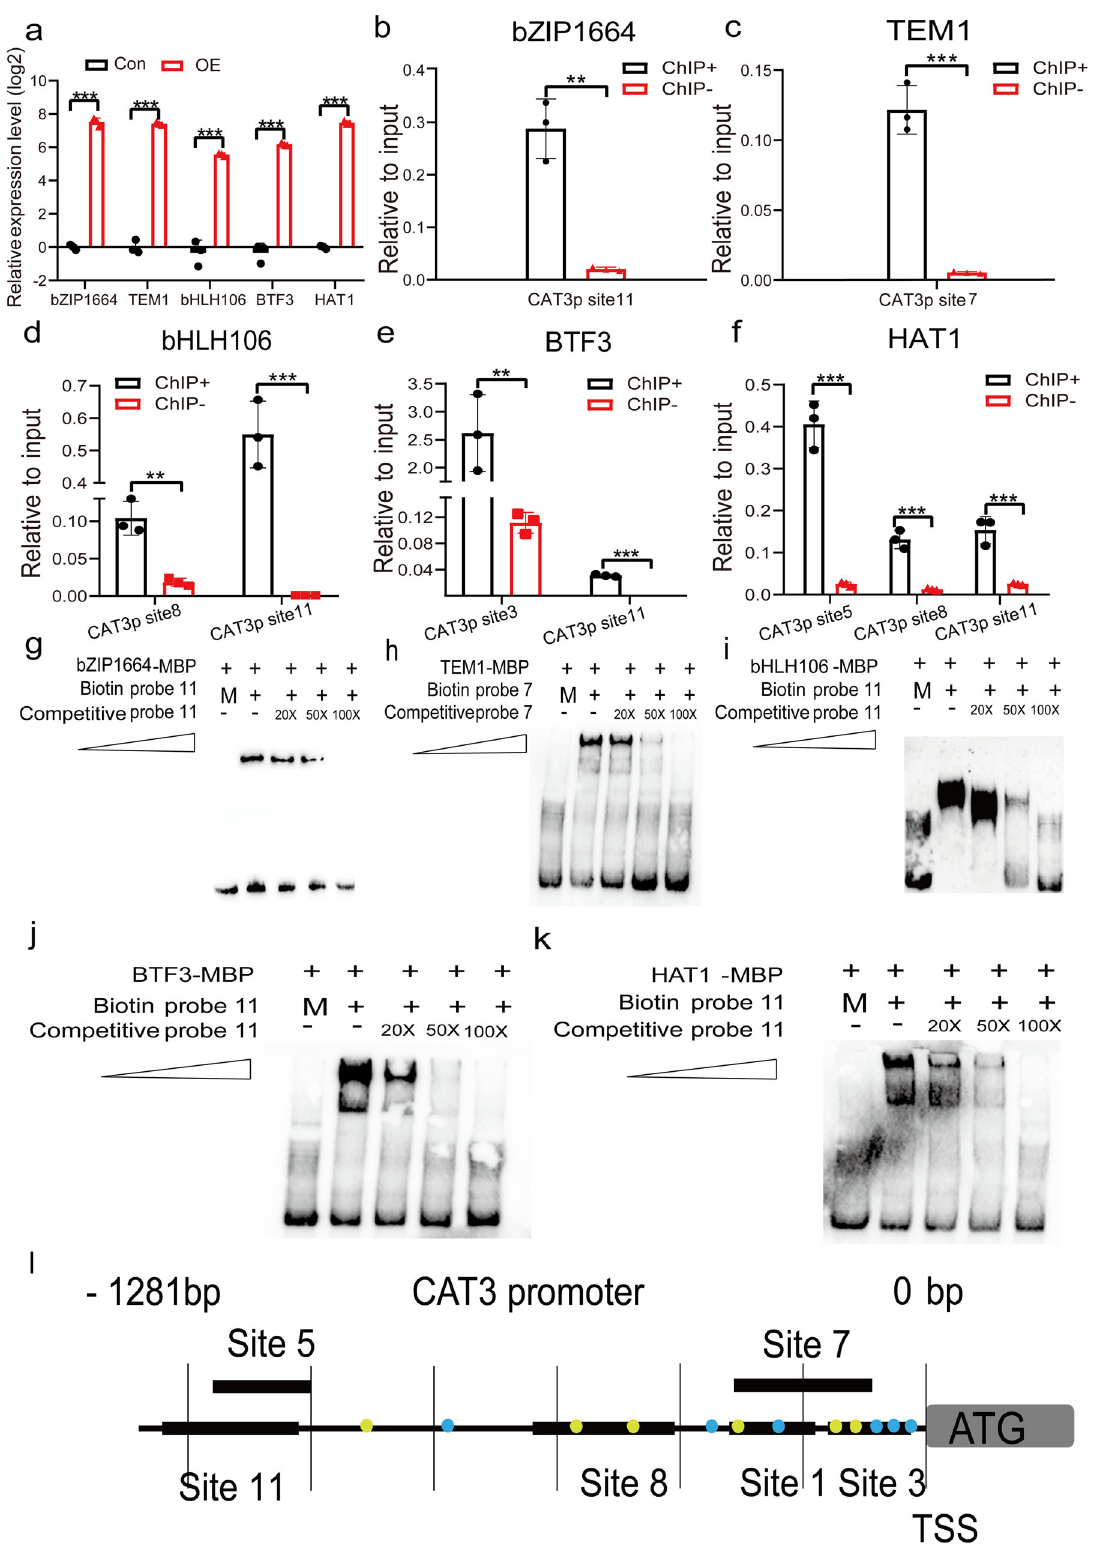
Electrophoretic mobility shift assay (EMSA) . To further con fi rm the binds of these fi ve TFs to the promoter of AtCAT3 , EMSA was performed. The different truncated promoters of AtCAT3 that were identi fi ed to be bound by the fi ve studied TFs in ChIP-qPCR were used as probes in EMSA, and the information of their length and location are shown as Supplementary Data 4. The